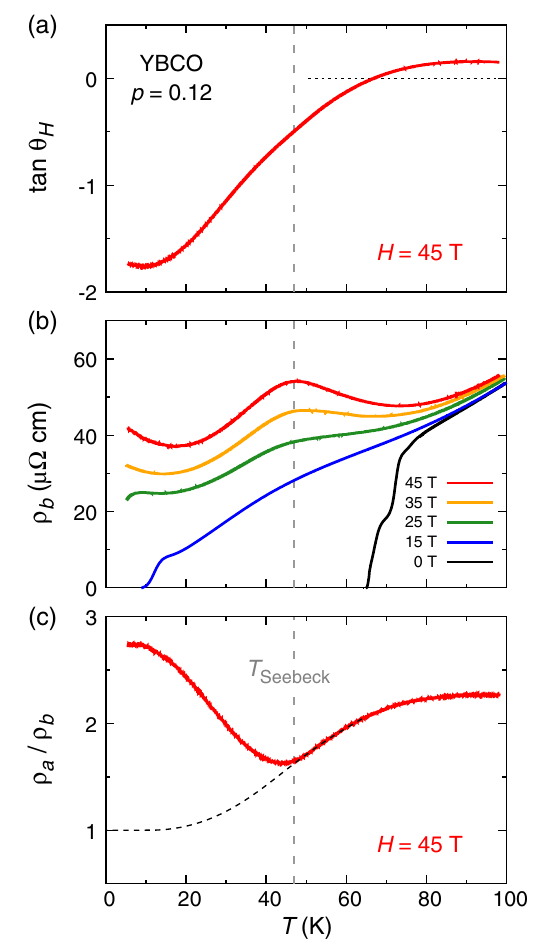
FIG. 6. (a) Tangent of the Hall angle, tan θ H ≡ ρ ab = ρ b , in YBCO at p ¼ 0 . 12 , plotted versus temperature at H ¼ 45 T, for a crystal with J ∥ b . The gray vertical dashed line in all three ¼ 47 K (Fig. 4). (b) Longitudinal resis- panels marks T Seebeck tivity ρ b measured in the same sample (with J ∥ b ), as a function of temperature for various magnetic fields as indicated. (c) In-plane anisotropy ratio, ρ a = ρ b , obtained from ρ b in (b) and ρ a measured with J ∥ a in a separate, nominally identical detwinned single crystal of YBCO at p ¼ 0 . 12 . The dashed line in (c) is a guide to the eye showing the smooth decrease in ρ a = ρ b expected if the in- plane anisotropy would come from only the CuO chains, whose disorder level is much larger than that of the CuO 2 planes, giving ρ = ρ → 1 . 0 as T → 0 a b